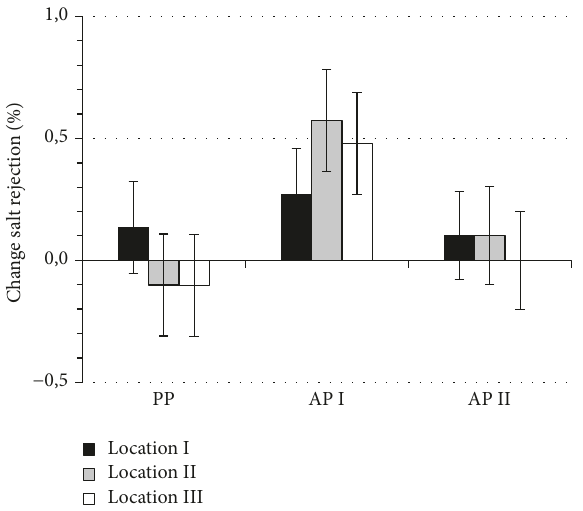
Figure 7: Change in salt rejection after standard plant cleaning procedure (PP) and two adapted cleaning procedures (AP I and AP II) for membrane and spacer samples from locations I, II, and III. Chemical cleaning of full-scale fouled membrane elements was performed in laboratory test cell; error bars represent standard deviation (𝑛 = 2)